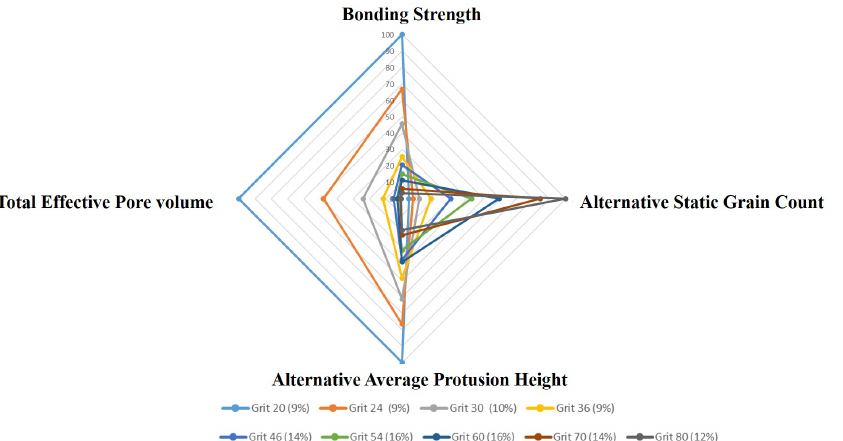
Figure 44. Radar chart optimised for maximum bonding strength and alternative static grain count at maximum compression; values in % of the maximum possible